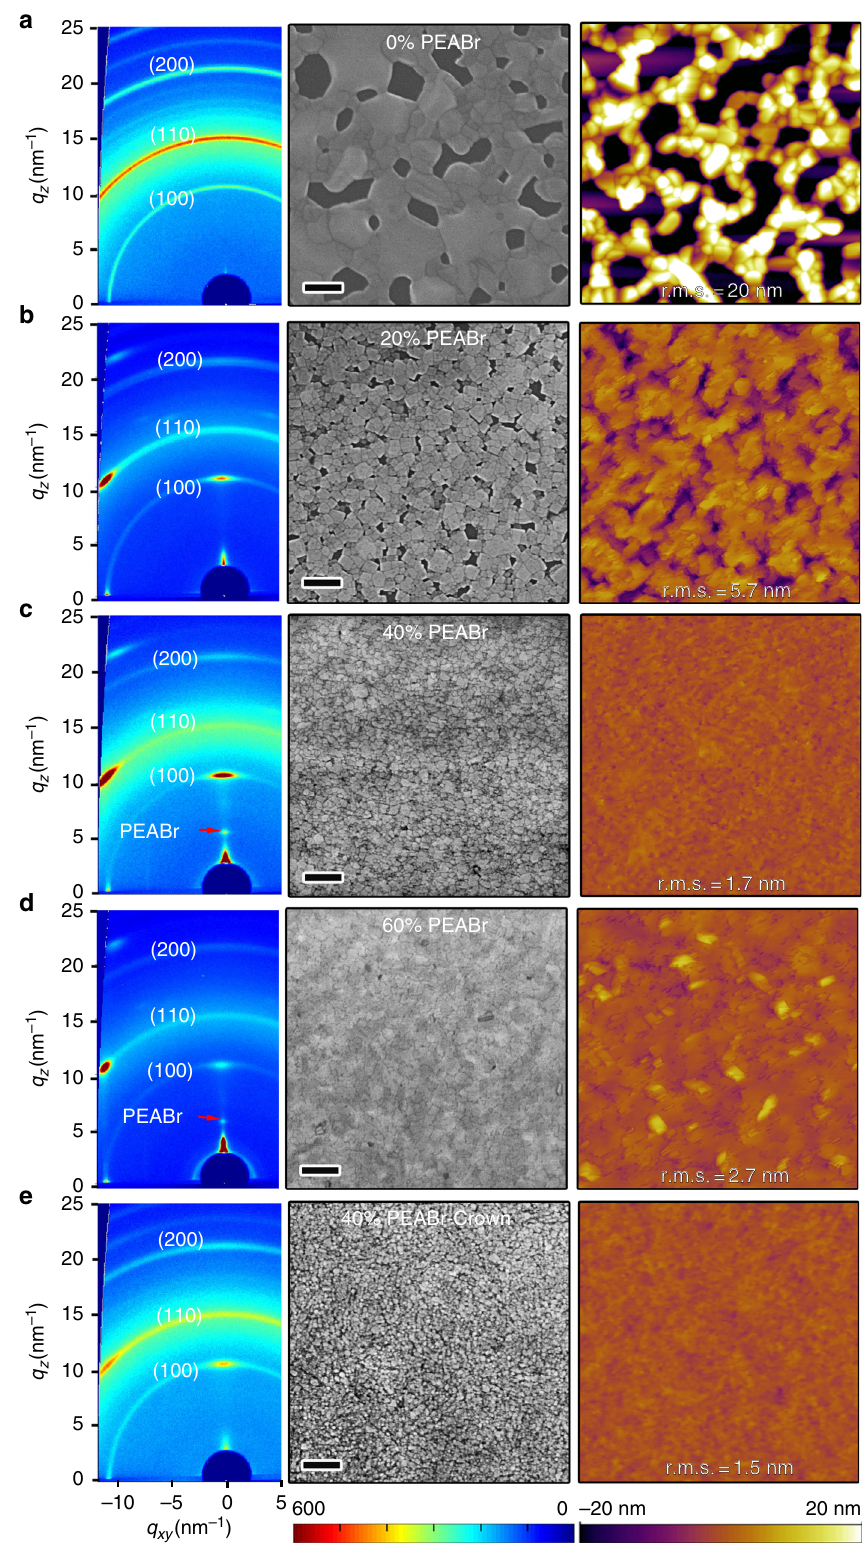
Fig. 1 2D GIXRD and morphology study of the perovskite fi lms. 2D GIXRD patterns (left), SEM (middle), and AFM (right) images of the perovskite fi lms with: a 0% PEABr, b 20% PEABr, c 40% PEABr, d 60% PEABr, and e 40% PEABr-crown. The PEABr molar ratio of x % PEABr means M The red arrows in the 2D GIXRD images highlight new diffraction peaks of PEABr at the high PEABr concentration. The scale bar of SEM images is 200 nm. The scan area of all AFM images is 2 µ m × 2 µ